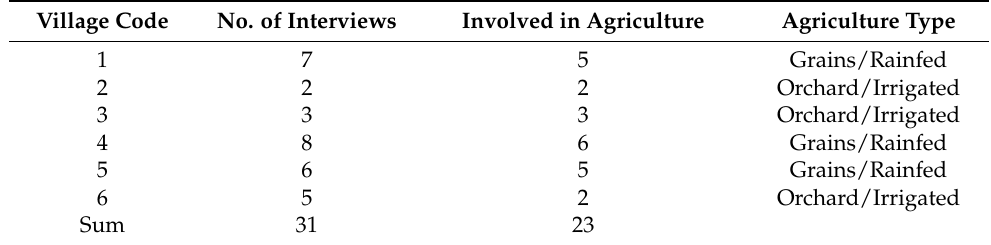
Table 1. Summary of village